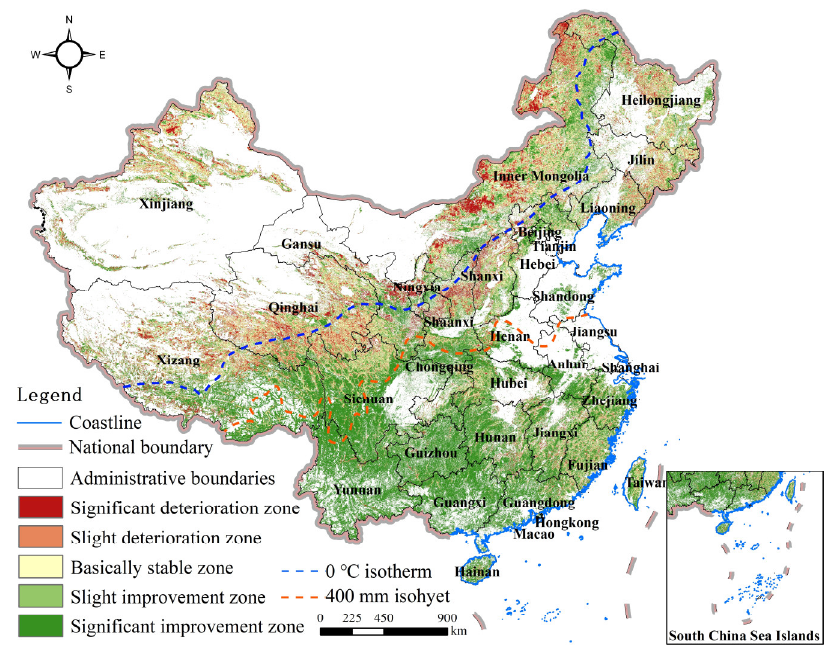
Figure 8. The interannual change rate of CS in CES.